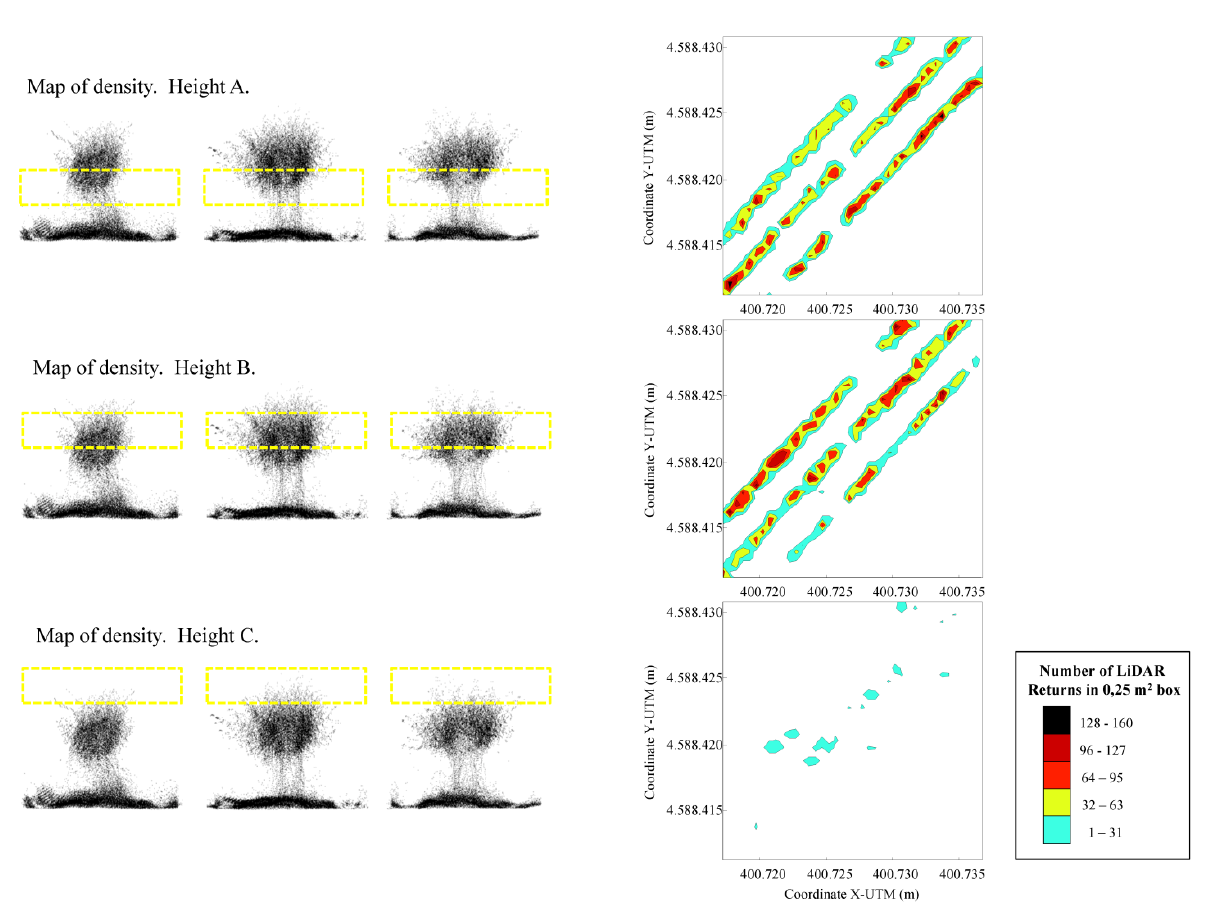
Figure 12. LiDAR return density obtained after LiDAR measurements can be split into the different heights obtained